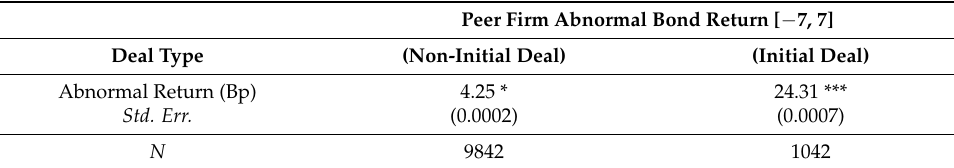
Table 7. Peer Firms’ Abnormal Bond Returns for Initial